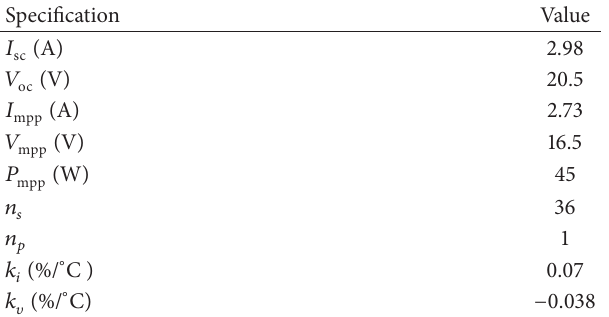
Table 1: Datasheet information of the solar panel ( 𝐺 =1000W/m 2 ; 𝑇 =25 ∘ C).